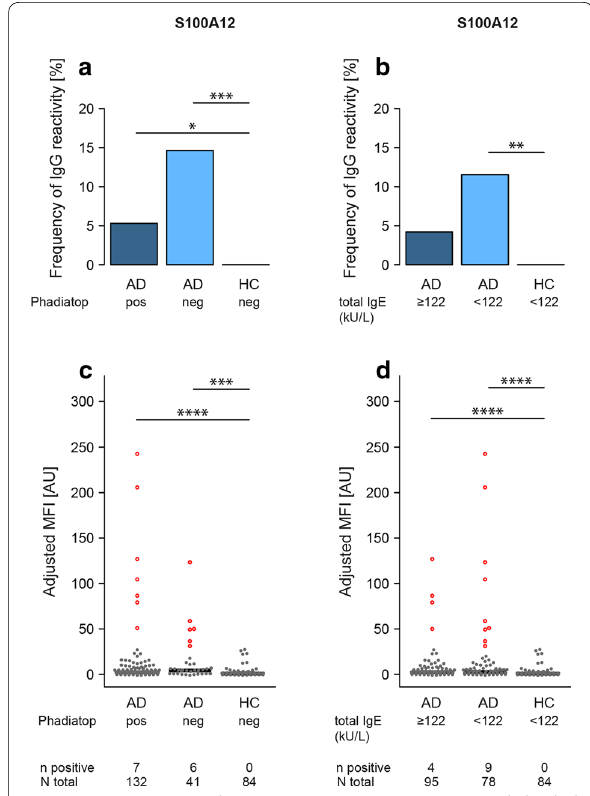
Fig. 5 IgG-reactivity to the antigen representing S100A12 subdivided by Phadiatop and total plasma IgE. Antigen showing significant difference in reactivity between healthy controls (HC) and atopic dermatitis cases (AD) or between HC and moderate (mAD) and/or severe (sAD) atopic dermatitis when analyzed using antigen bead arrays. The frequency (%) of subjects with IgG-reactivity to S100A12 subdivided by Phadiatop ( a ) or total plasma IgE ( b ). The adjusted median fluorescence intensity (MFI) of all subjects subdivided by Phadiatop ( c ) or total plasma IgE ( d ). Adjusted MFI was defined by subtracting the sample median across all protein fragments from each signal and dividing the result by the MAD. Subjects with positive reactivity are highlighted in red. The number of subjects with positive reactivity out of the total is indicated below each figure. Significant P values of pairwise group comparisons indicated by * P < 0.05,